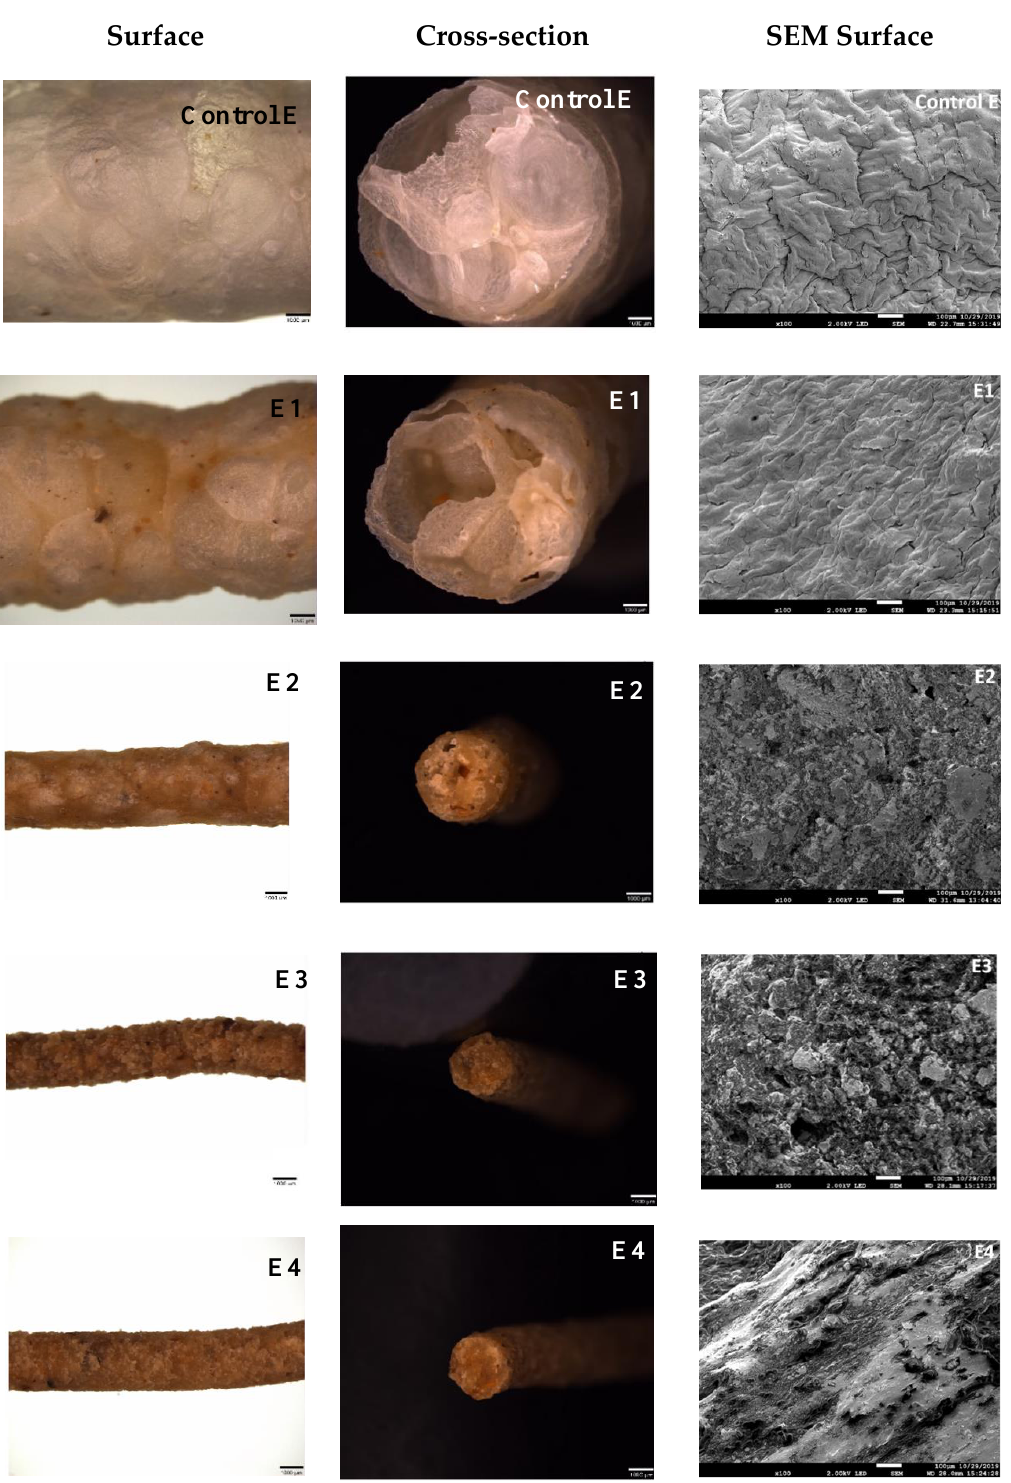
Figure 4. Stereoscopic images of surface and cross-sectional areas (1 × magnification) and SEM micrographs (100 × magnification) of the surface area of extruded samples containing di ff erent levels of tiger nut. Bottom bars in the pictures are referred to magnification, which is described above for better